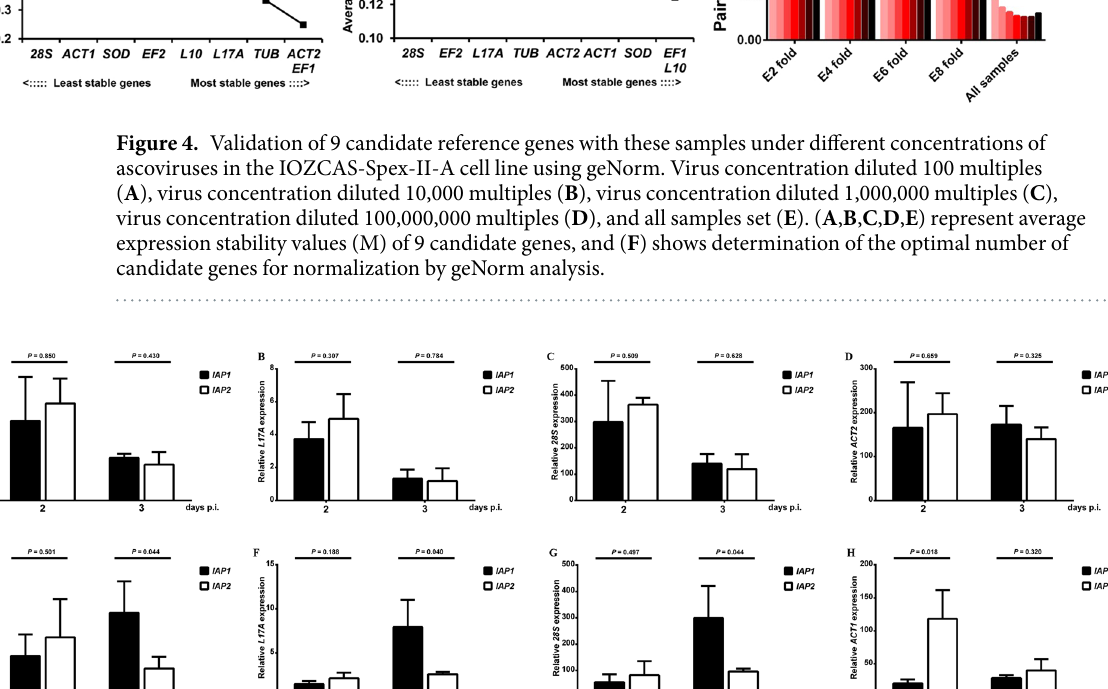
instars of S. exigua were significantly easier to infect with HvAV-3h compared to the later instars, using 10-fold serial dilutions (0 to 7) of HvAV-3h-containing hemolymph to infect S. litura larvae. There were no significant differences in larval mortalities from 10 0 - to 10 3 -fold dilutions; however, significant declines were observed at the 10 4 -fold dilution and above 7 . Compared to the healthy larval population, the typical symptoms and survival times of the diseased larval population were considerably extended, food intake was significantly reduced, and the body weight remained fairly constant in the 3 rd and 4 th instar larvae, which happened after inoculation with the ascovirus. However, the corrected mortality rates for the 1 st through 5 th instar inoculated per os were very low 8 . Therefore, the ascovirus mode of dissemination, which relies on the parasitoid wasp M. similis , served as a vector when the female parasitoid wasp acquired the virus. The ovipositor with the virion viability was 4.1 ± 1.4 days, and infected host larvae were still acceptable for egg laying by parasitoids. The parasitoids thereafter trans- mitted the virus to healthy hosts 26 . It follows that ascoviruses, with this dissemination system, have probably been regarded as significant for long-term pest control. Moreover, there are few studies that have elucidated the